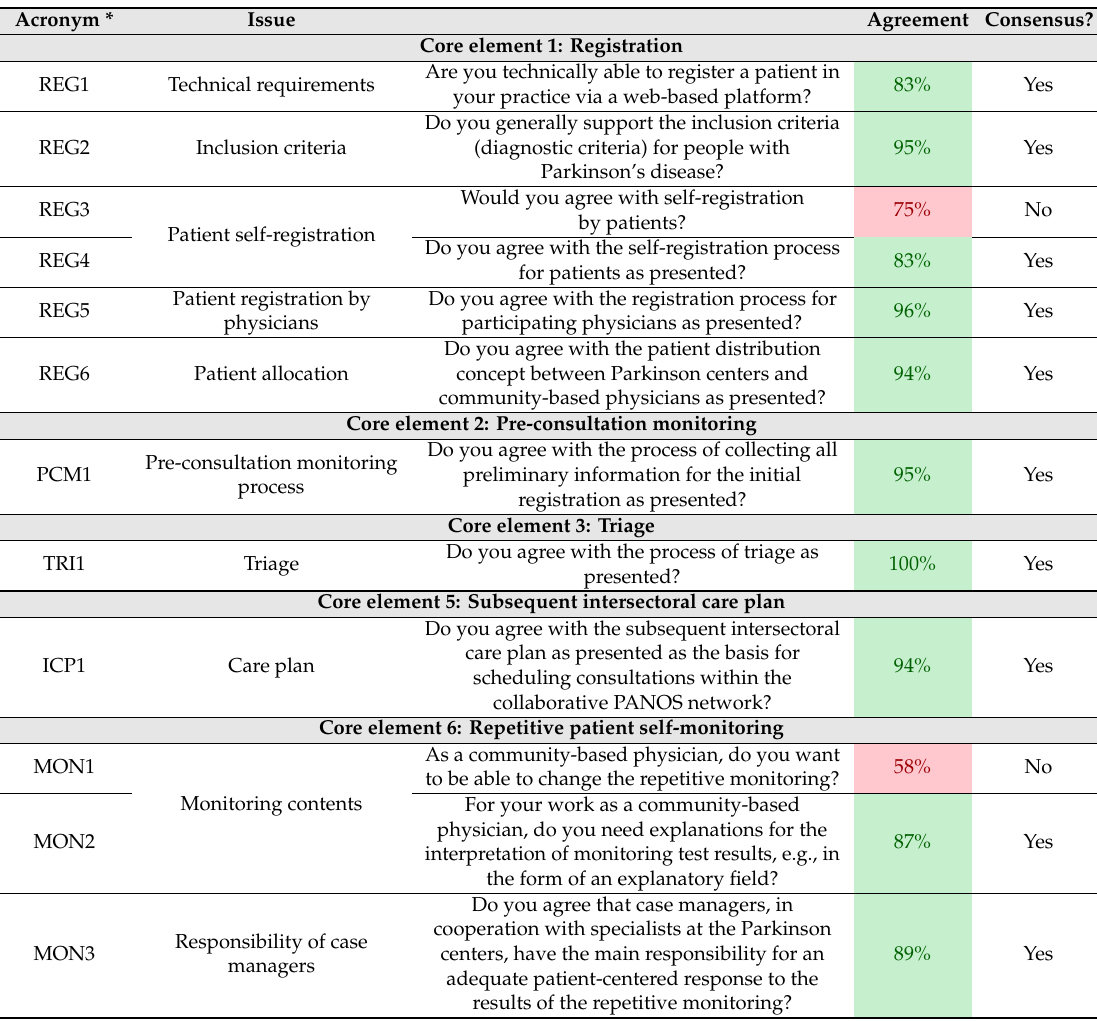
Table 4. Results of Tele-Dialog (TED) voting—core elements of the PANOS patient